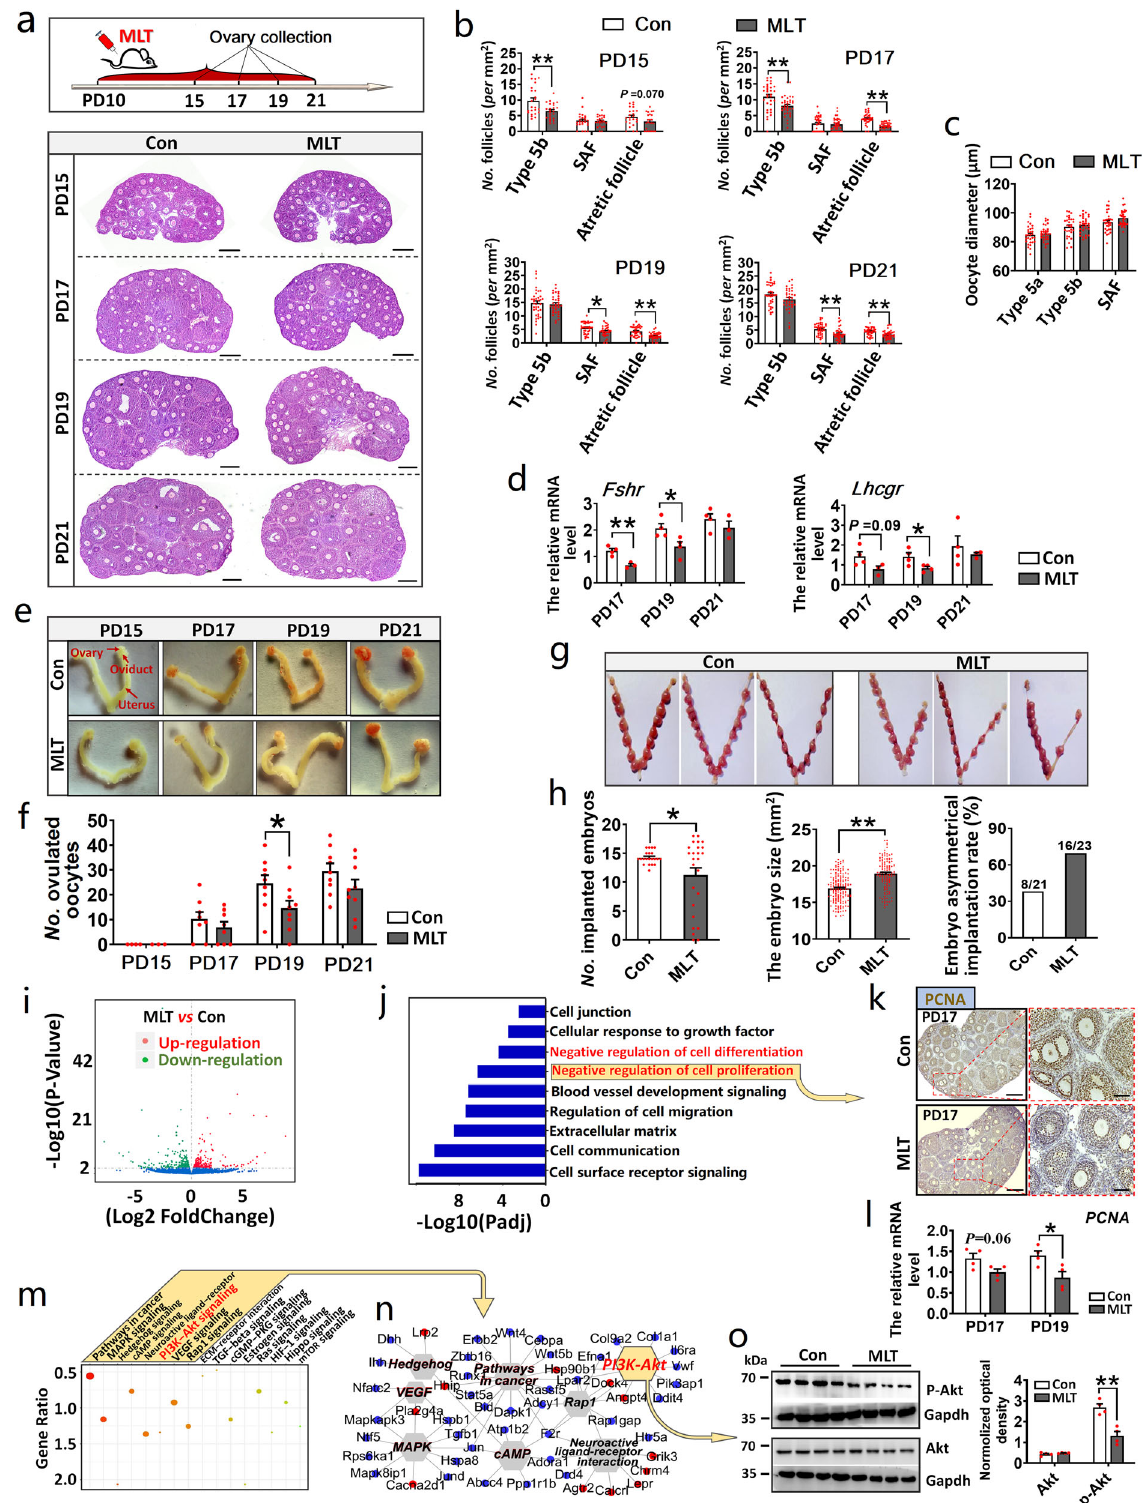
signi fi cant decrease in the number of follicles ( P = 0.0018) (Fig. 5m, n). Nobox , Ddx4 , and Figla , which were solely expressed by oocytes, were the marker genes that re fl ected the total number of oocytes in the ovary. Among those genes, the expression levels of Nobox and Figla in SNAT -KO ovary was lower than that in the wild type ( P = 0.0156 and 0.0598, respectively) (Fig. 5o). The above phenotypic, histological, and molecular data